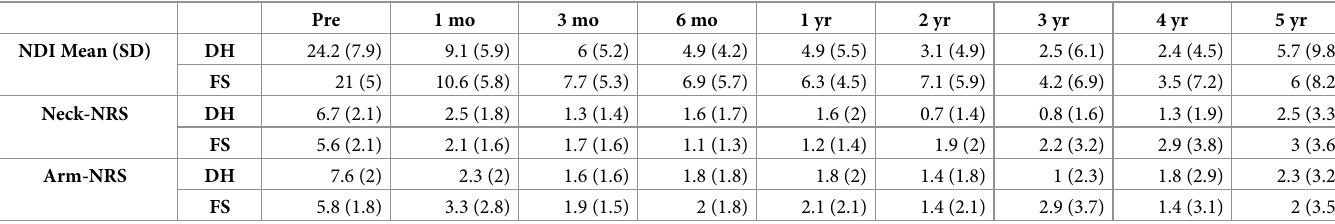
Table 2. Clinical outcomes: Adjusted mean (standard deviation) �